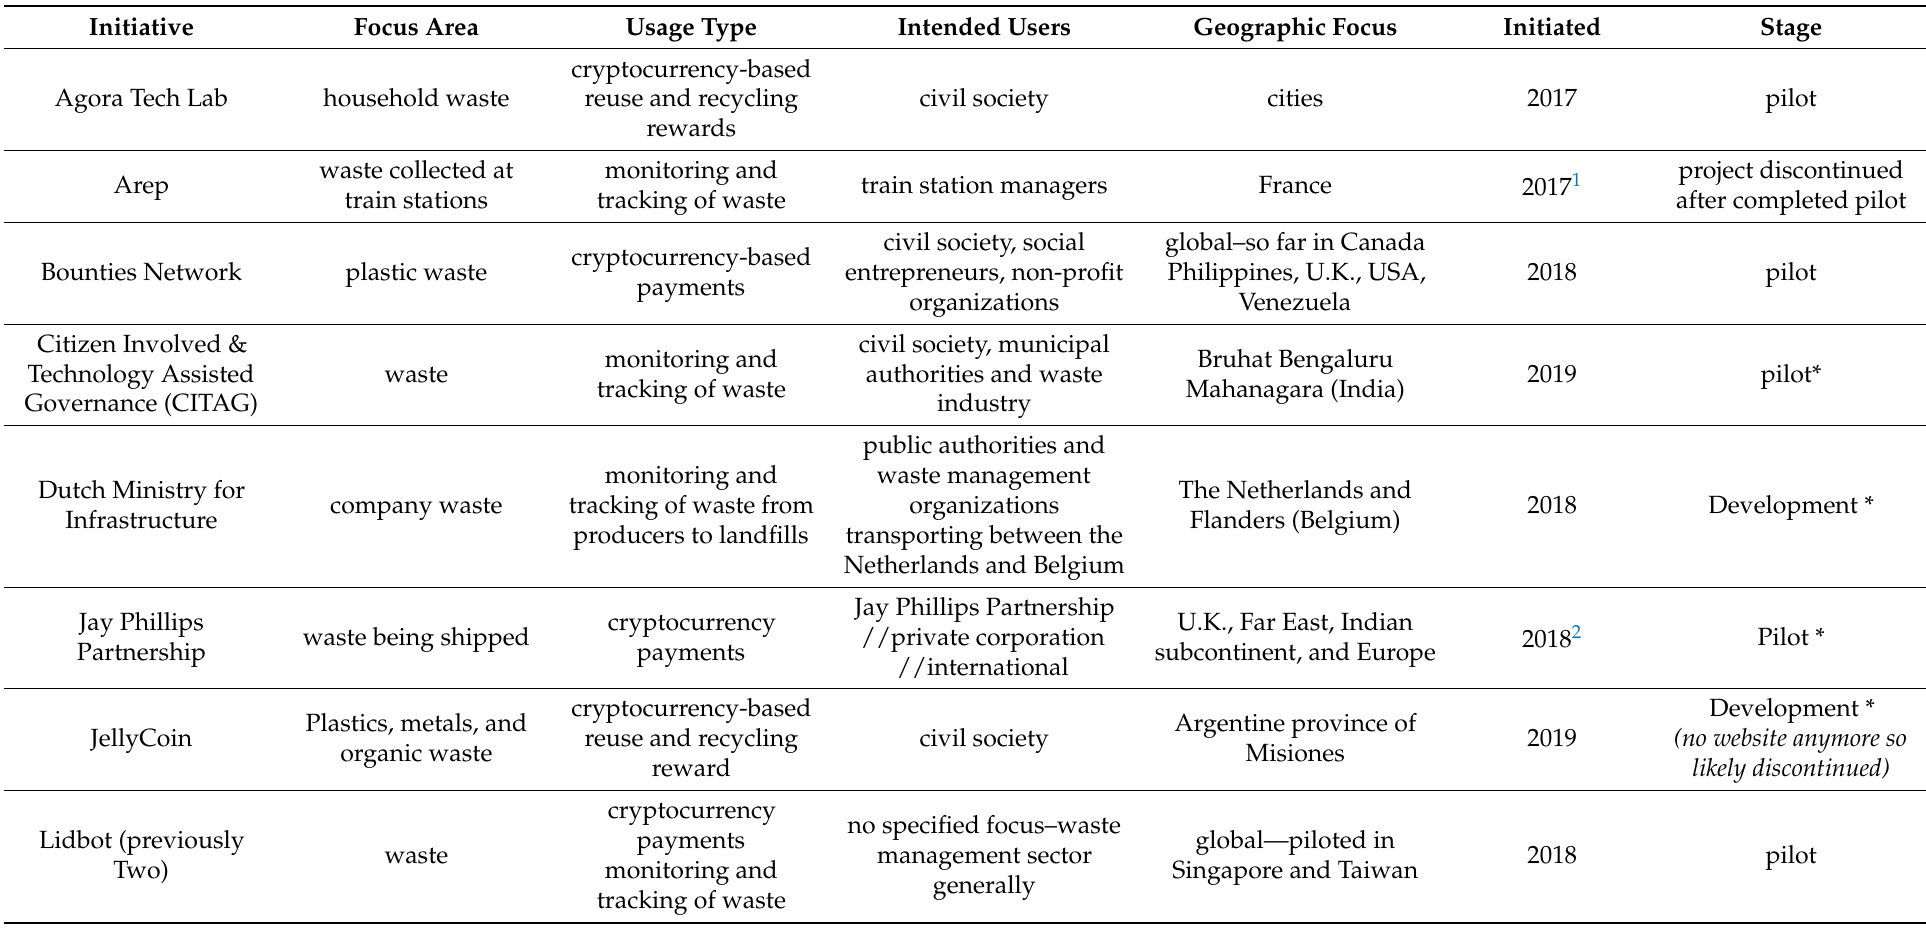
Table 1. Overview of 21 existing blockchain technology applications to waste management. Italicized text indicates that the date is based on when the initiative was first reported rather than necessarily when it was founded; an asterisk (*) indicates there is no recently updated information since the initiative was first reported